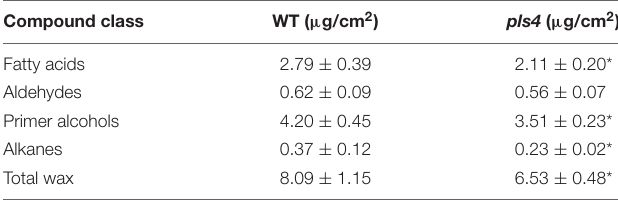
TABLE 1 | Leaf blade of the heading stage cuticular wax composition and loads in WT and pls4 mutant. Compound